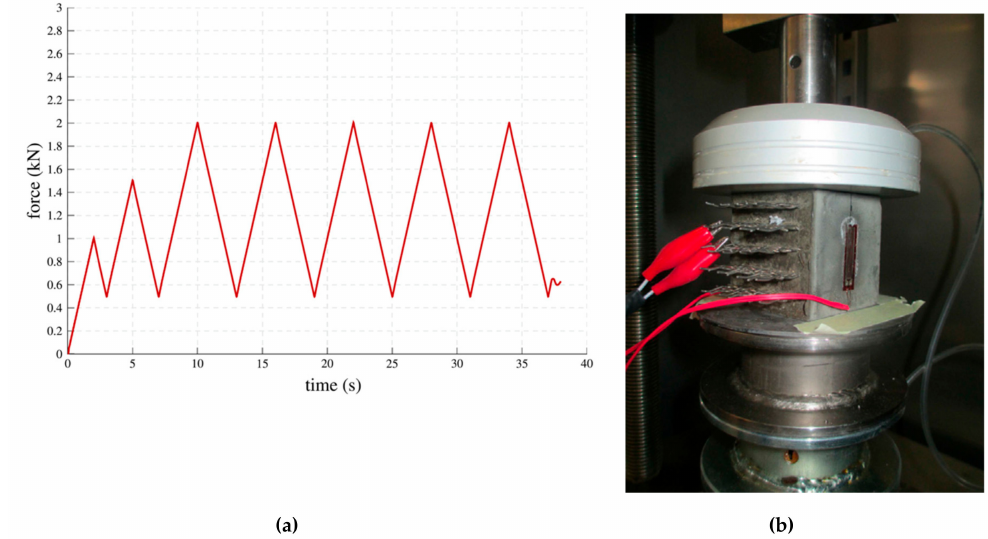
Figure 20. ( a ) Compression load versus time and ( b ) uniaxial testing machine used in the MWCNTs reinforced cement-based specimens. Reprinted with permission from [124]. Copyright © 2017, Elsevier